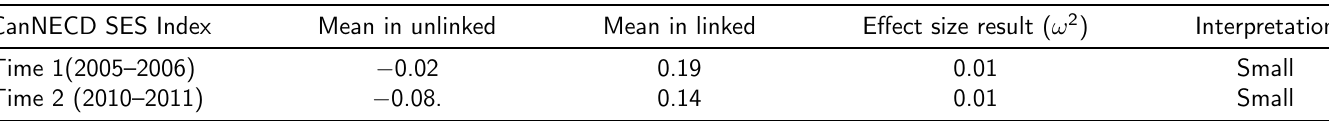
Table 5: Effect sizes ( ω 2 ) of differences in CanNECD SES Index between unlinked ( n = 170 , 865) and fully linked ( n = 86 ,